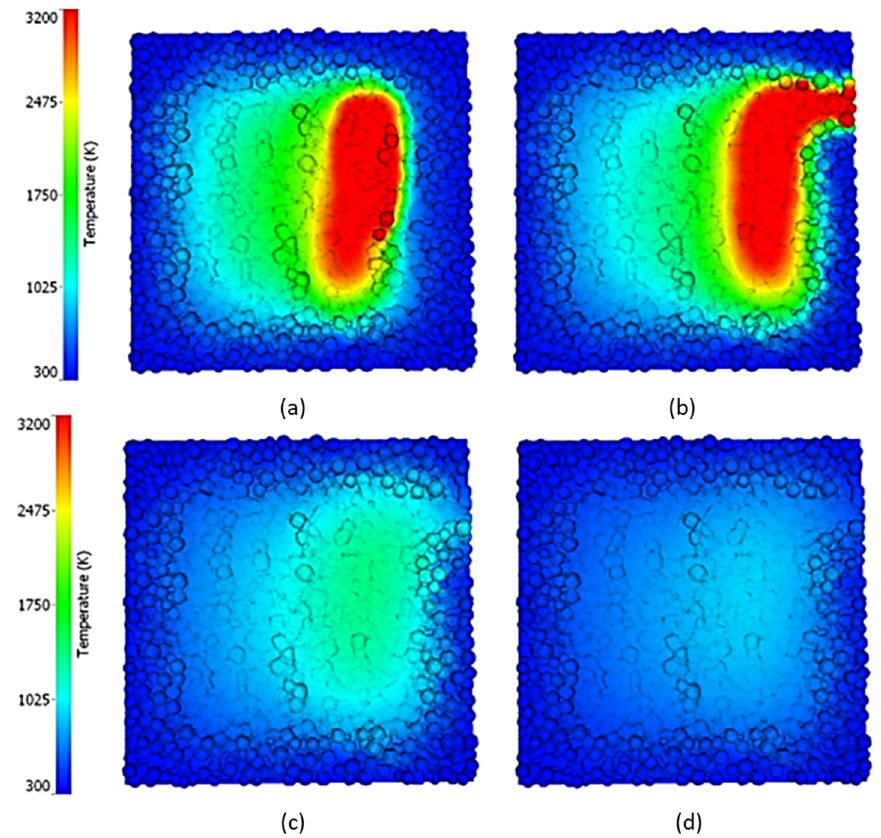
Figure 7. Temperature of the powder bed calculated by SPH following a laser scan over Ti-6Al-4V powder grains for selected times from the start of scan at time = 0 s [35]. Laser power = 114 W and scan speed = 0.6 m/s. Time steps (ms) extracted here are for: ( a ) 12, ( b ) 14, ( c ) 18 and ( d ) 22.